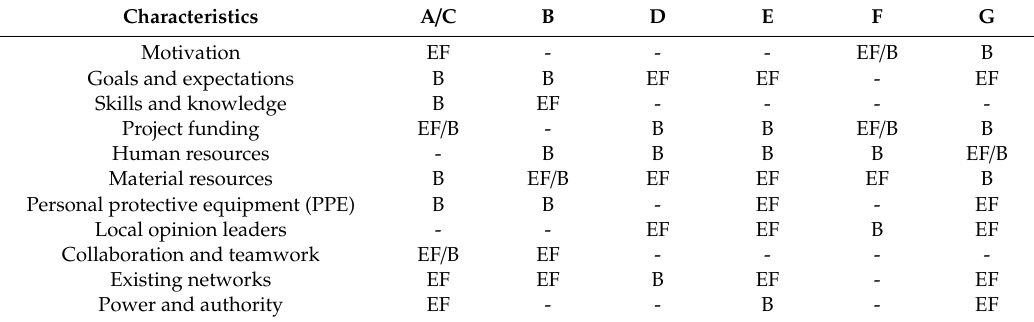
Table 3. Recipient construct characteristics and whether they were enabling factors (EF) and / or barriers (B) to the implementation of HealthWISE in each participating hospital (A–G).